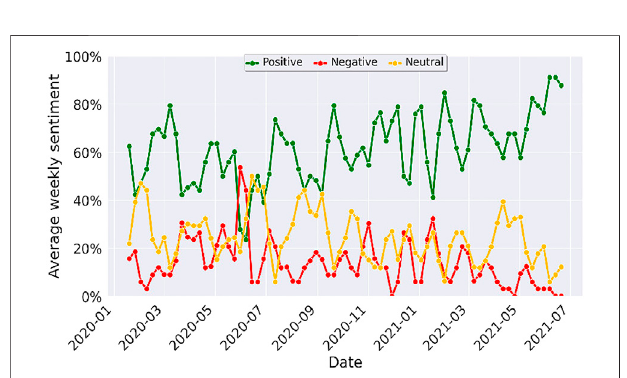
FIGURE 4 | Temporal variation in public sentiments on policing